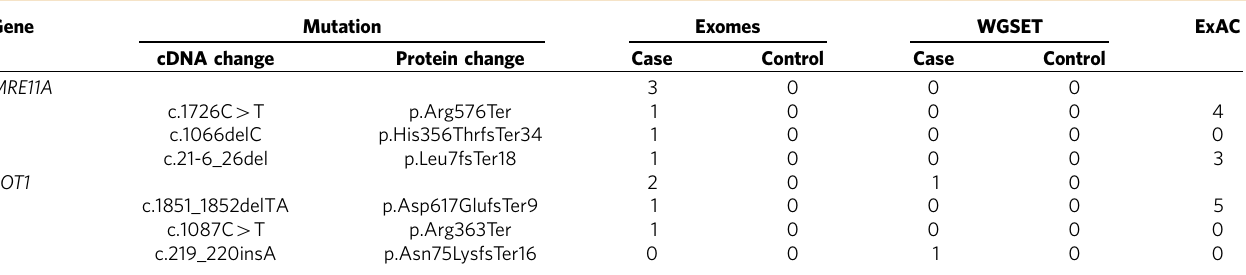
Table 2 | Disruptive mutations identified in novel candidate CRC susceptibility genes.